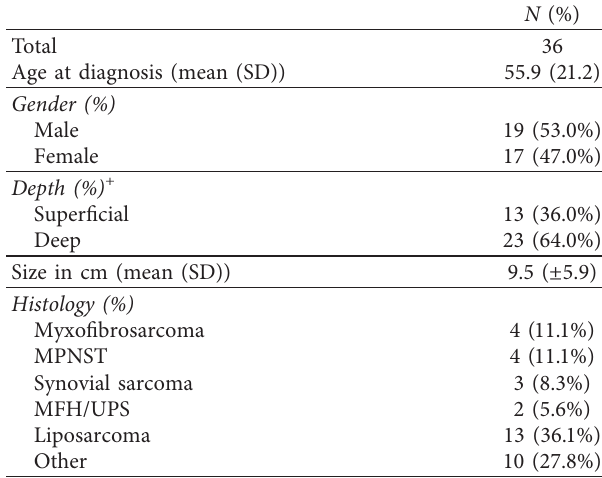
+ Depth: relative to the investing fascia; N: number of patients; MFH/UPS: malignant fibrous histiocytoma/undifferentiated pleomorphic sarcoma; MPNST: malignant peripheral nerve sheath tumor.